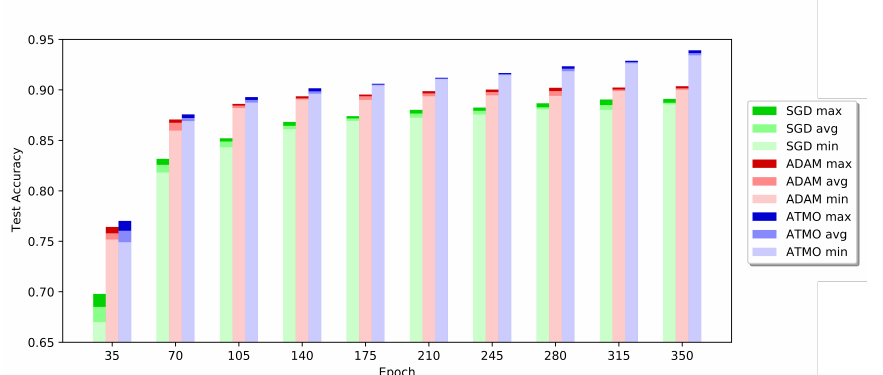
Figure 5. Resnet18 test accuracies min, max, and avg computed every 35 epochs using all experiments.